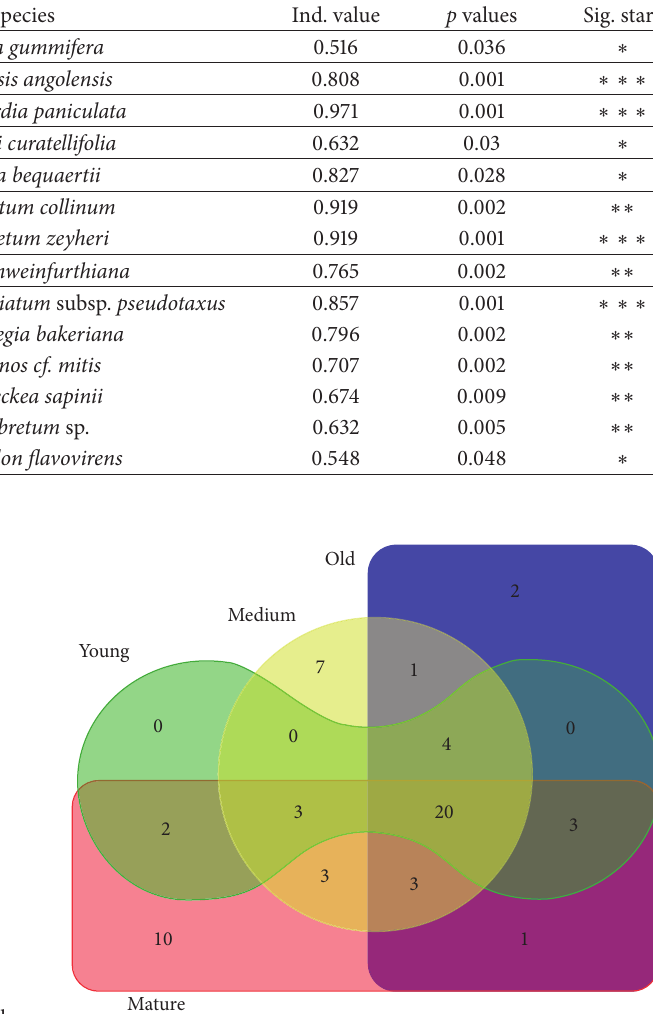
Table 2: Indicator species, 𝑝 values, and significance stars [ ∗ ] of single and combined groups of fallows stages and mature stands as observed in the Cusseque area.